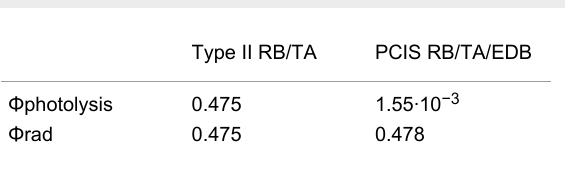
Table 3: Calculated photolysis and radical quantum yields of the Type II and the